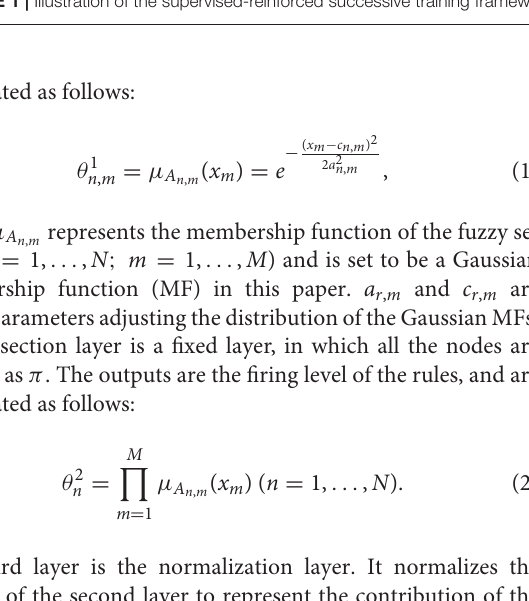
FIGURE 1 | Illustration of the supervised-reinforced successive training framework for the multi-continuous-output TSK fuzzy inference system